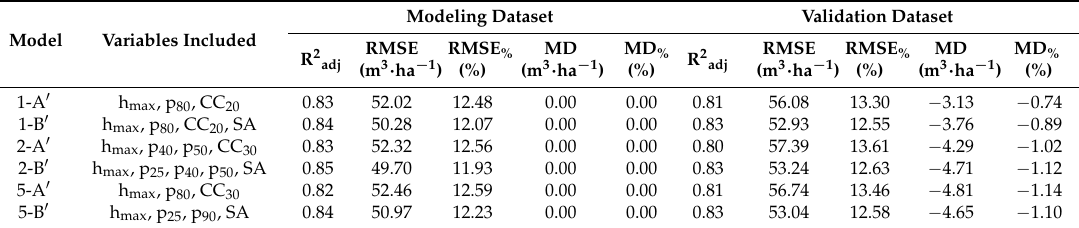
Table A3. Results of the stepwise regression (on the modeling dataset) and of the validation (on the validation dataset) for the six selected stand-level volume models (double-log models, i.e., models with the logarithmically transformed dependent and independent variables).